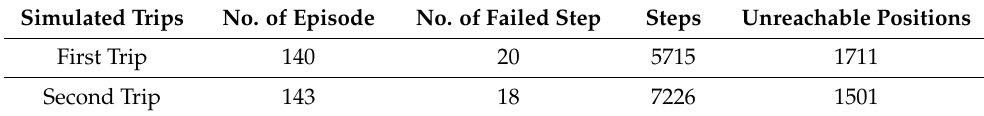
Table 4. Total number of episodes and steps per